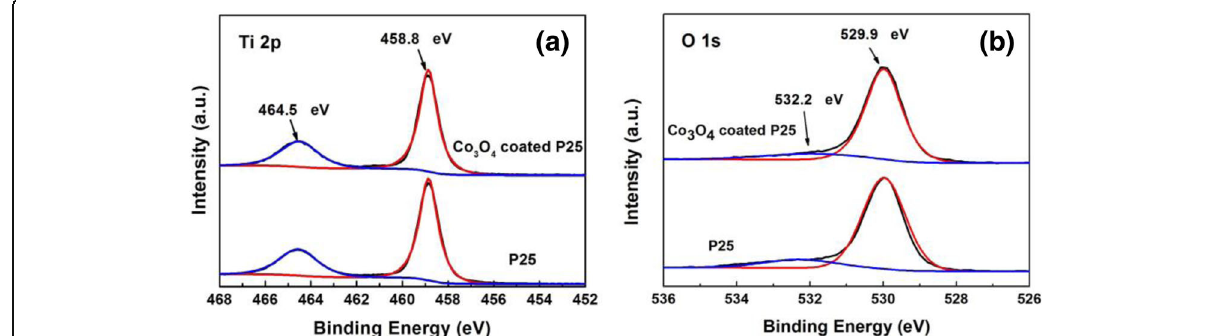
Fig. 3 XPS spectra of 100-cycle Co 3 O 4 -coated P25 powders and pure P25 powders. a Ti 2p. b O